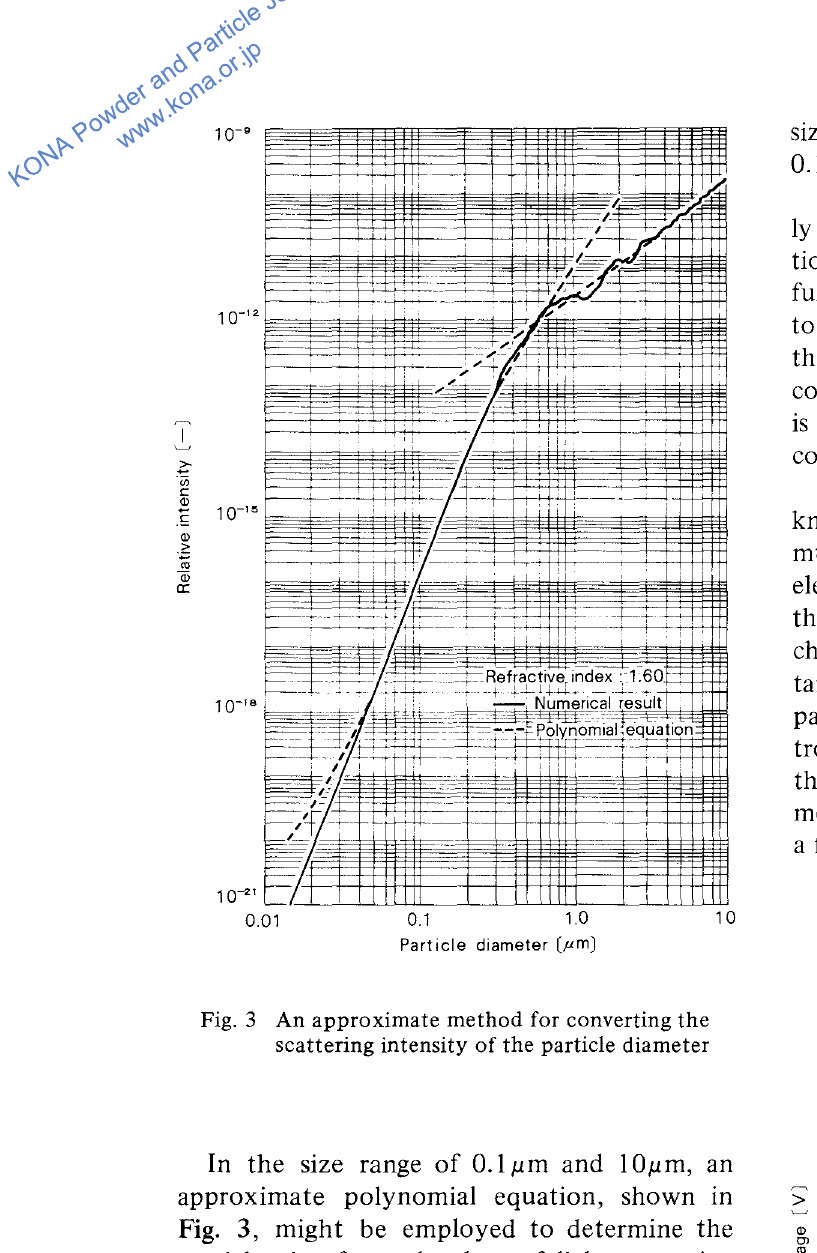
In the size range of 0.1 Mill and lOJ,Lm, an